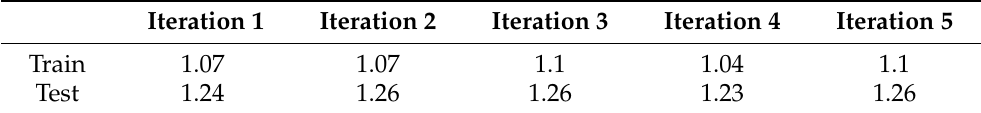
Table 5. Average RMSE behavior in training and test sets in five different iterations for the GRU (250 Cells) + Dense model. The number of sequences in batch train was set to 100 in all cases.